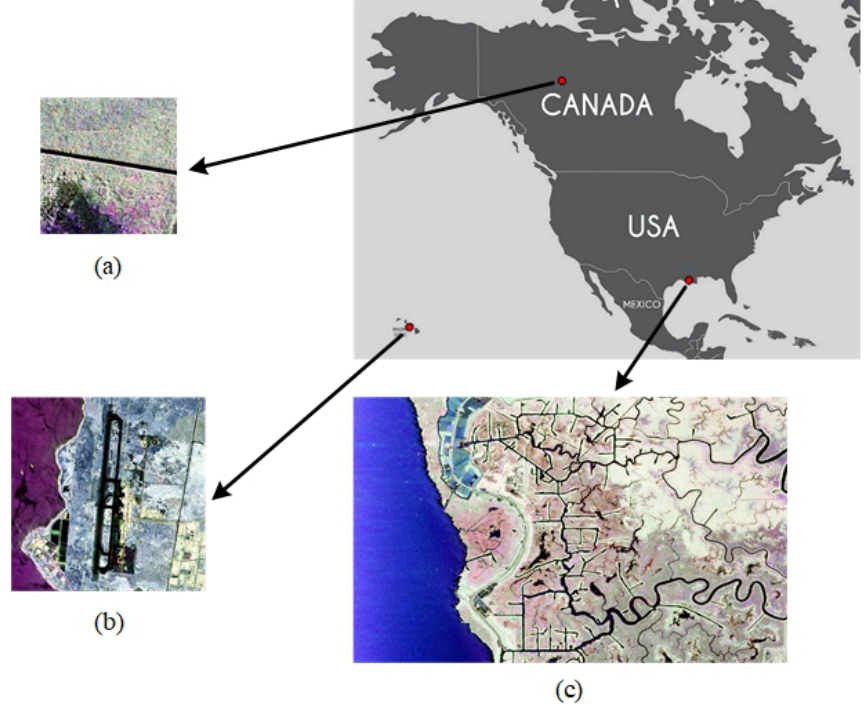
Figure 8. PauliRGB images of the three PolSAR data. ( a ) Simple road area. ( b ) Kona airport. ( c ) Complex river